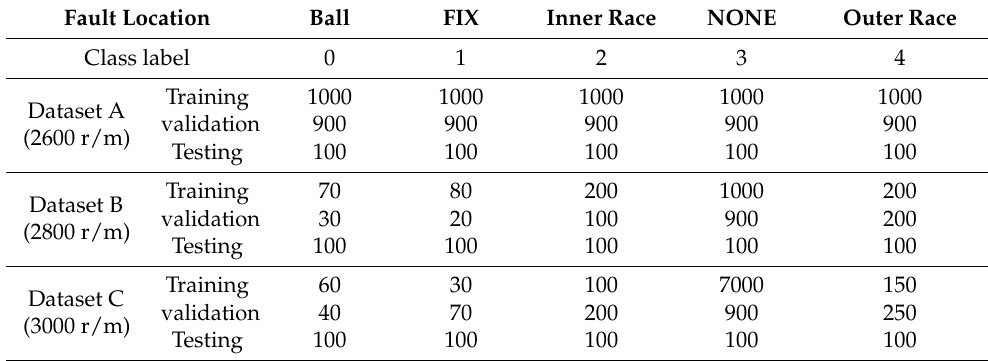
Table 5. Bearing dataset